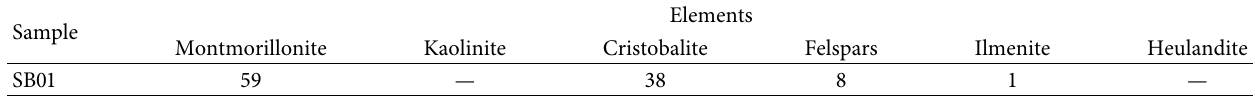
Table 8: Mineral composition (wt. %) of Sabga smectite.